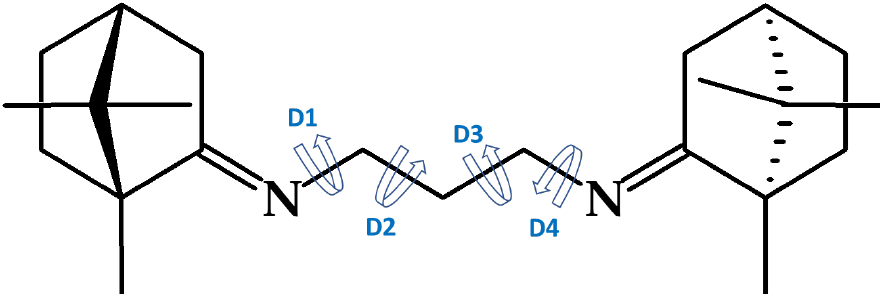
Scheme 1. Biscamphorolidenpropylenediamine {(1 R ,2 E ,4 R )-1,7,7-trimethyl- N -(3-{[(1 R ,2 E ,4 R )-1,7,7- trimethylbicyclo-[2.2.1]heptan-2-ylidene]amino}propyl)bicyclo [2.2.1]heptan-2-imine}